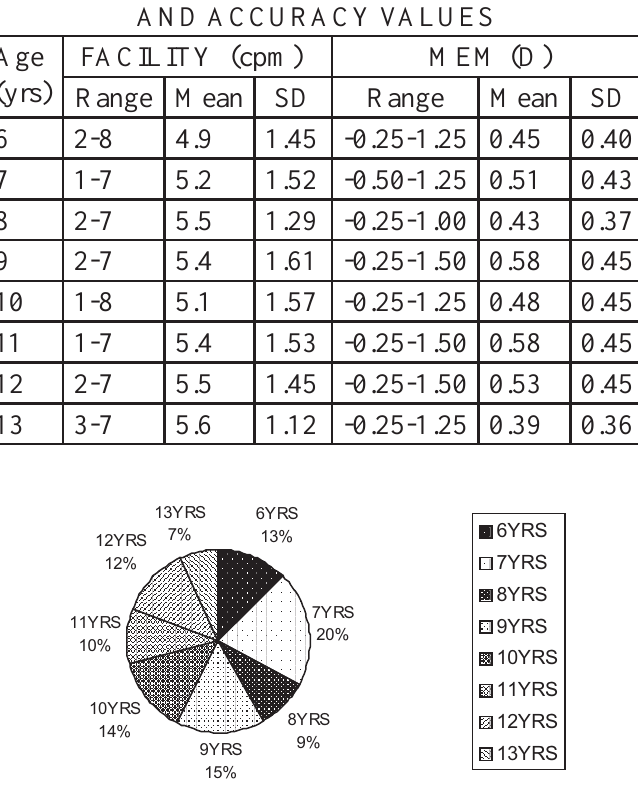
Table 2: Shows the mean, ranges and standard deviations of the accommodation facility and accuracy findings.